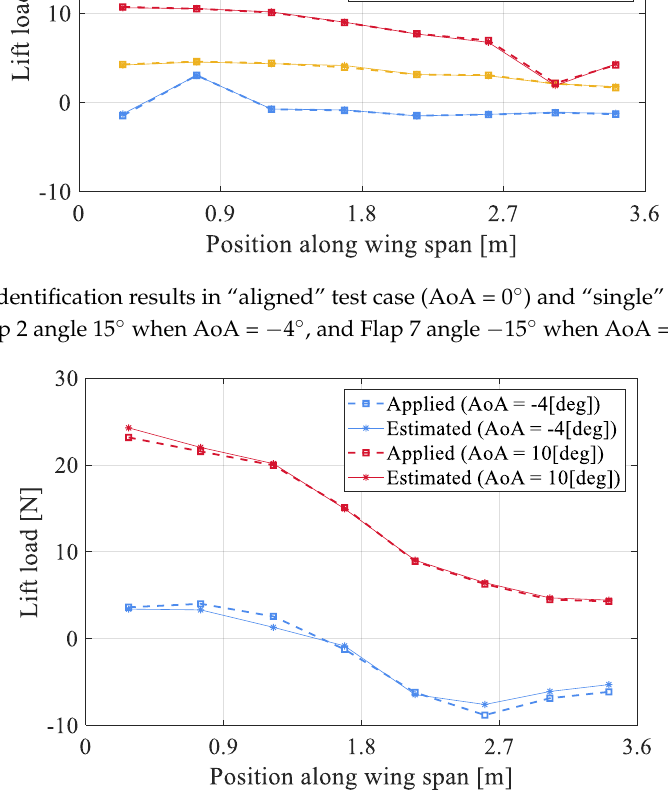
Figure 10. Load identification results in “controlled” test cases with AoA = − 4° and 10°.